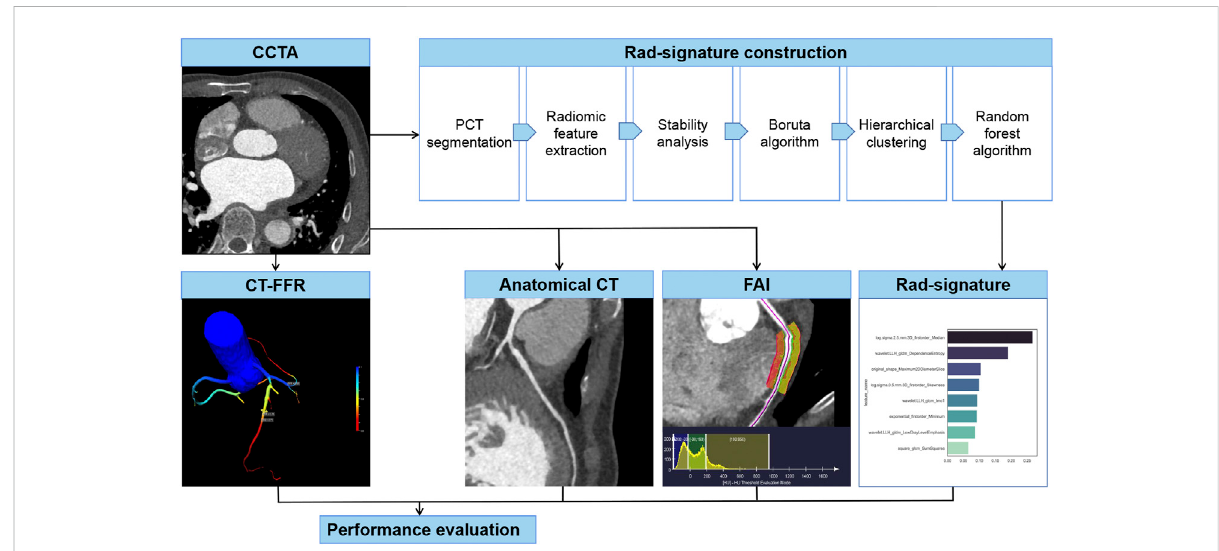
FIGURE 2 Establishment and evaluation of anatomical CT, FAI, and Rad-signature. CCTA, coronary computed tomography angiography. PCT, pericoronary tissue. CT-FFR, CT-derived fraction fl ow reserve; FAI, fat attenuation